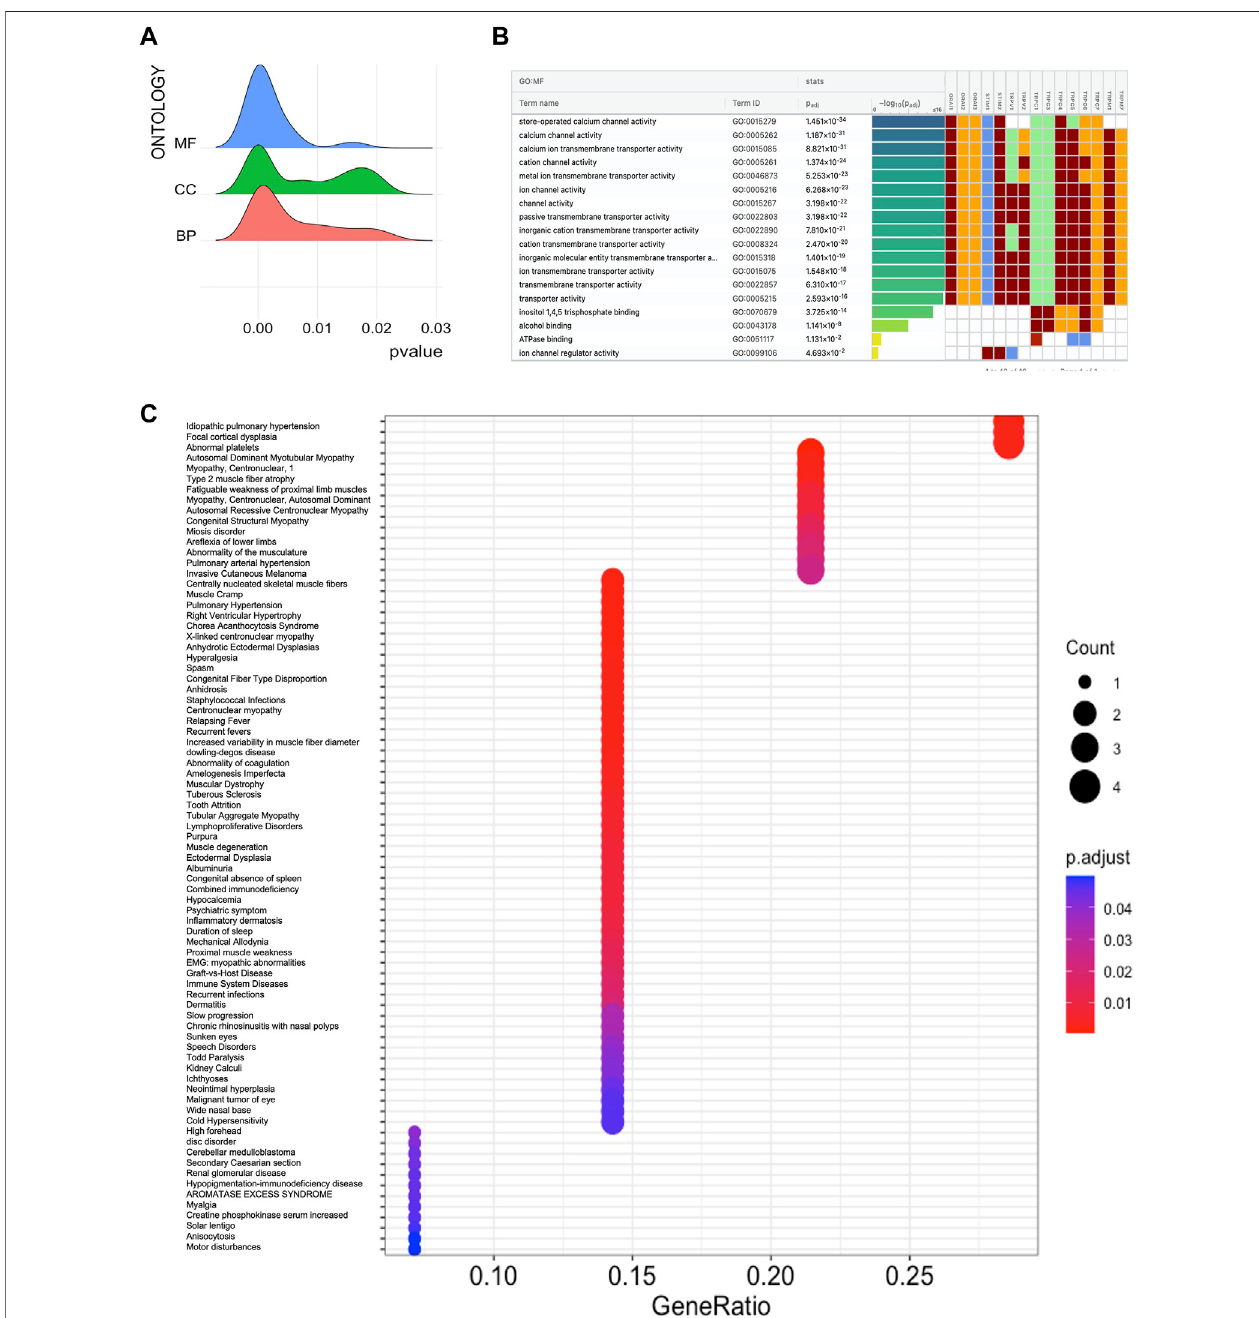
FIGURE 1 | Molecular function and disease ontology of SOCs. (A) Ridge plot showing the predominant Gene ontology analysis using ClusterPro fi le R package. Inset- MF: Molecular function (blue); CC: Cellular component (green); BP: Biological processes (orange) (B) Gene ontology analysis using g:Pro fi ler. Molecular function (MF) whichshowedsigni fi cantadjusted p -valueofSOCs isshowed. Cumulativehypergeometric padjvaluesareusedtodentifythemostsigni fi cantmolecular functions. The − log 10 padjcolumniscoloredaccordingtotherankwithhighestbeingpurpletolowestbeingyellow.Thecolorforeachgeneisgivenasfollows:redforinferred fromtheexperiment;brownforSequenceModel(ISM),SequenceAlignment(ISA),SequenceOrthology(ISO)orSequenceorstructuralsimilarity(ISS),Genomiccontext (IGC) or Biological aspect of ancestor (IBA), Rapid divergence (IRD); blue for Reviewed computational analysis (RCA), Electronic annotation (IEA); green for traceable author or non traceable author or inferred by curator (C) Disease enrichment analysis of SOCs using ClusterPro fi le R package. The enriched diseases with p value less than 0.05 areshown. The dots represent the enrichmentofgeneswith red color being high enrichment and blue being low enrichment.The size ofthe dot represent the count of each term in the particular row.